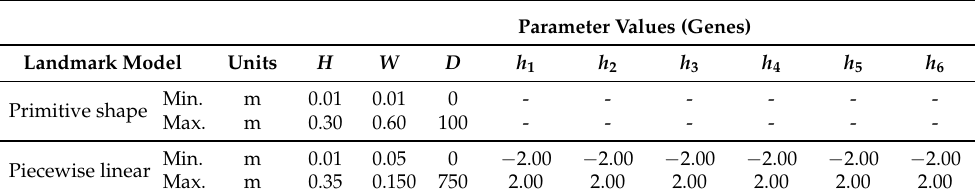
Table 1. Minimum and maximum parameter values for the landmark models.